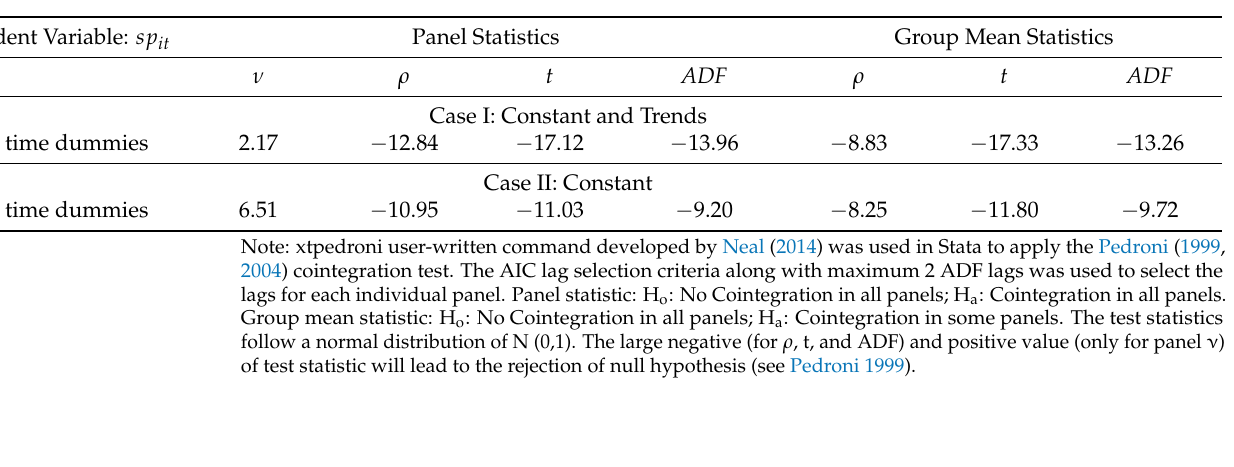
Table 5. Pedroni (1999, 2004) Residual-based cointegration